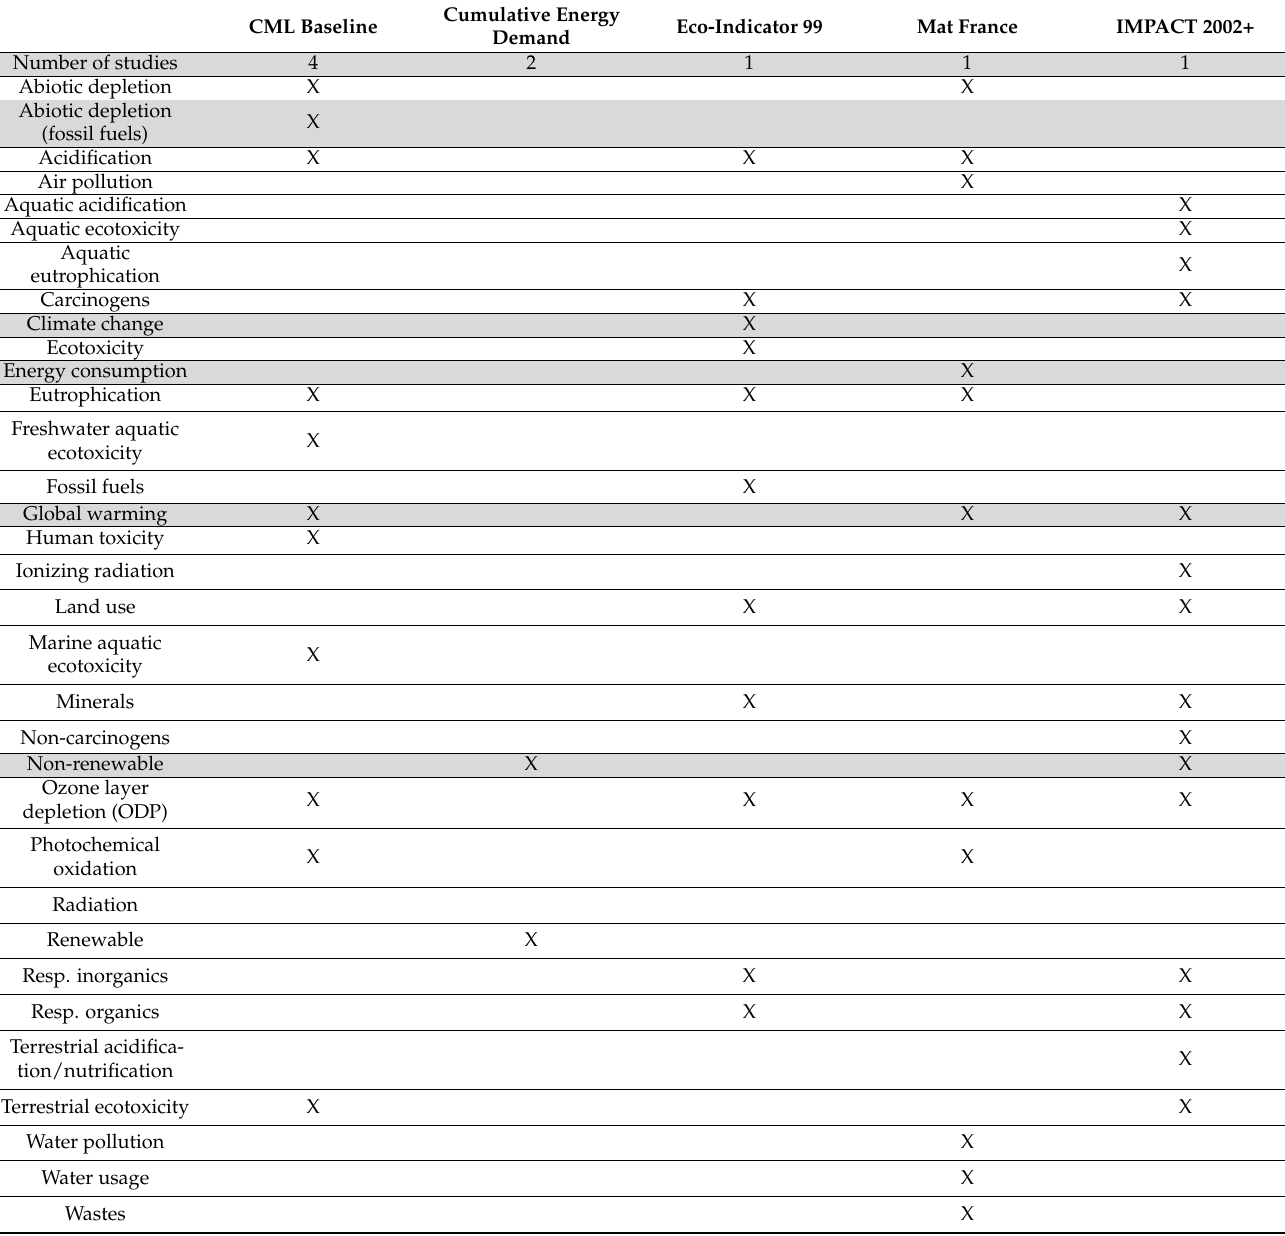
Table 4. Environmental impact assessment categories from each impact assessment